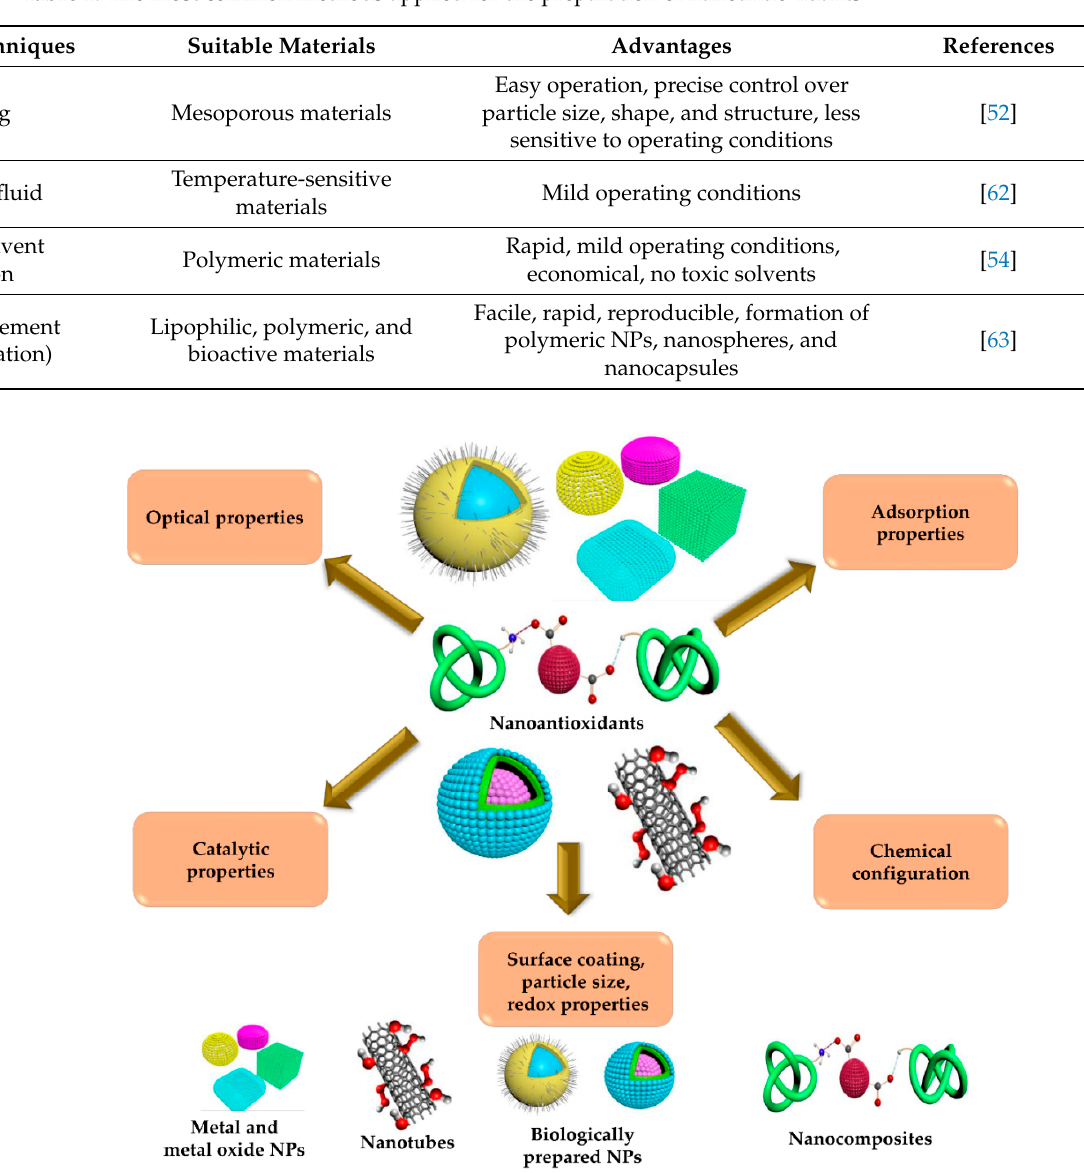
Table 1. The most common methods applied for the preparation of nanoantioxidants.